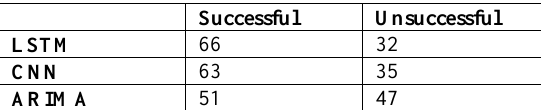
Table 2: 2019 USD/TRY Exchange Rate Results of